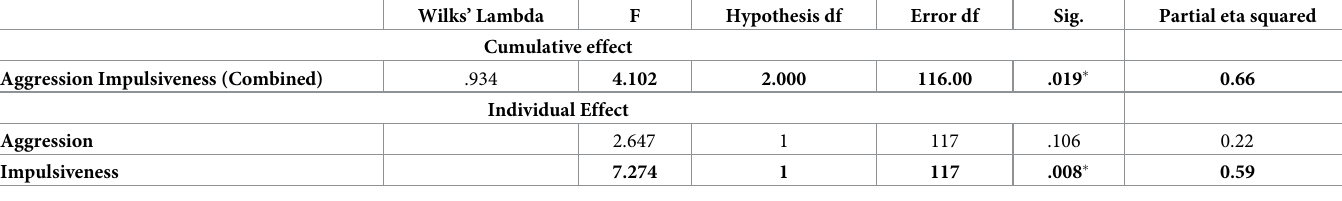
Table 4. Association analysis between among personality factors and outcome of suicide attempt multivariate analyses of variance (MANOVA